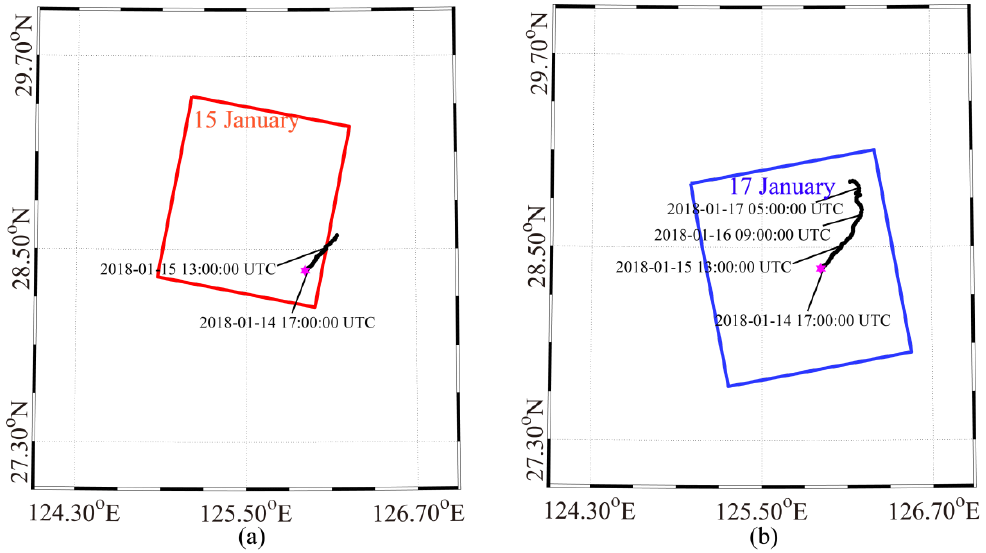
Figure 7. The spreading track of simulated oil slicks using the oil particle-tracing method ( a ) during the period from 14 to 15 January 2018 ( b ) during the period from 14 to 17 January 2018. Table 1. The comparison of spatial coverage between SAR-detected and model-simulated oil slicks.